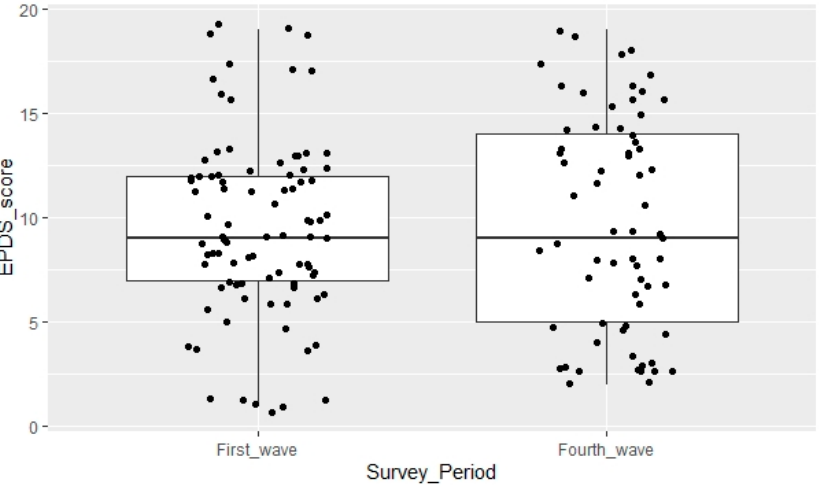
Figure 1. Mean EPDS score among the two survey groups: first wave of the COVID-19 pandemic in Romania (1 October–14 October 2021), respectively. Table 2. Description of EPDS score results among the 154 participants surveyed in the two periods.